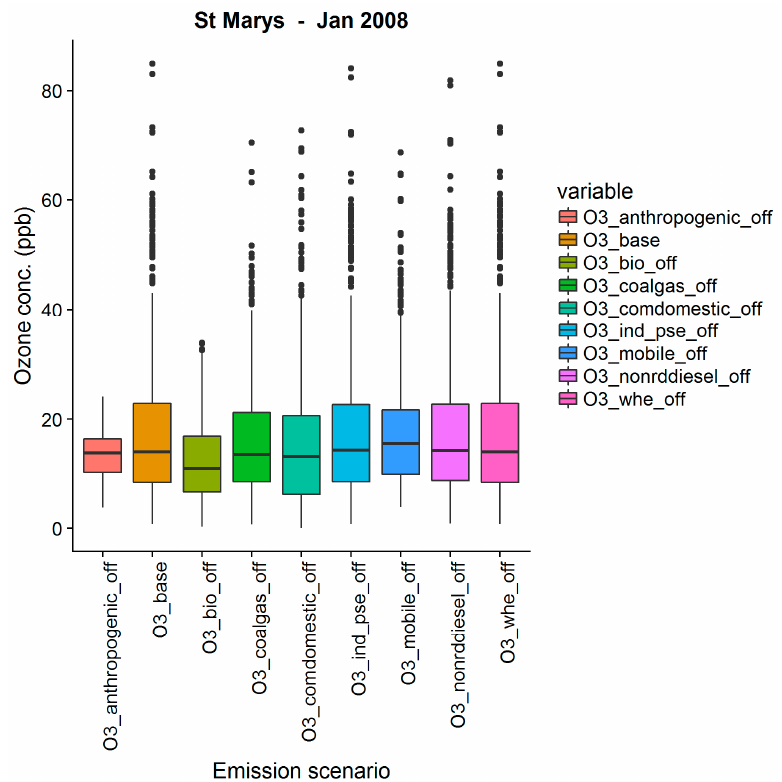
Figure A2. Box plot for 1-h ozone concentration (ppb) in January 2008 under different emission scenarios at St Marys.